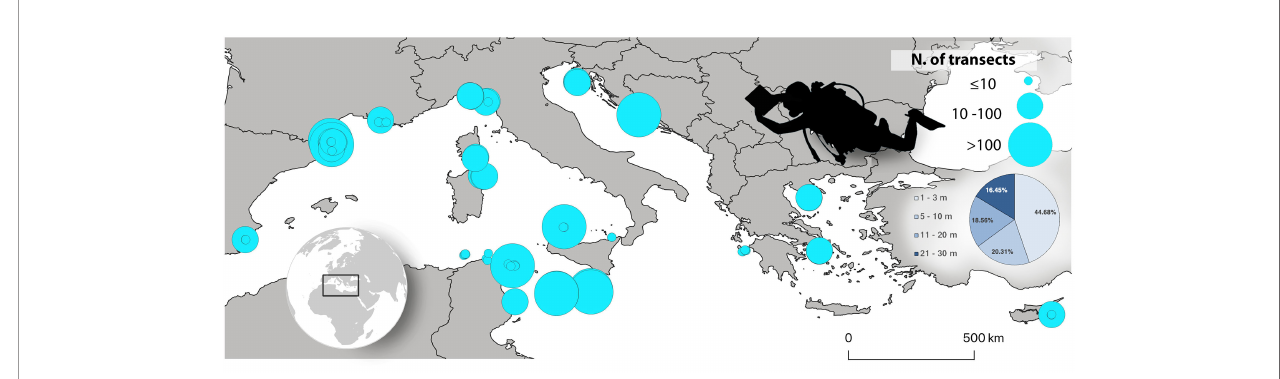
FIGURE 2 | ClimateFish study areas. The total number of transects carried out in each permanent location is illustrated by the size of the circles. The percentage distribution of the number of transects per depth